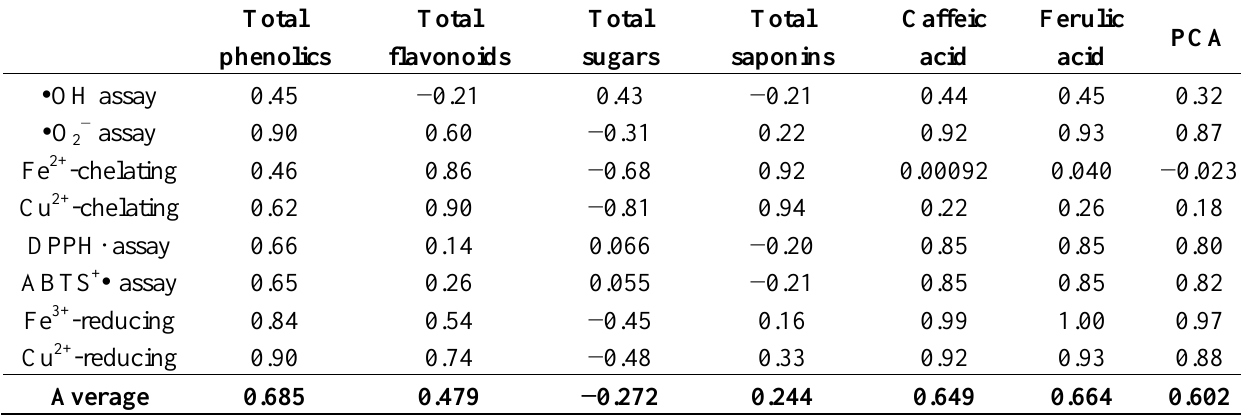
Table 3. The R (correlation coefficient) values between chemical contents and antioxidant